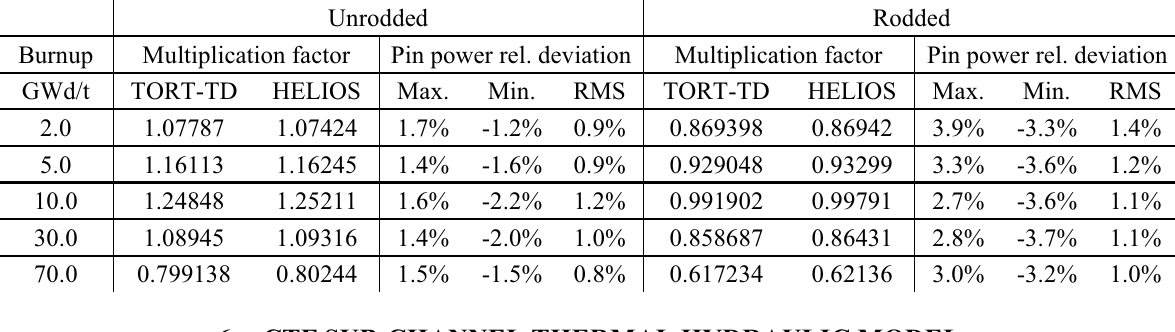
Table 2. TORT-TD multiplication factors as well as maximum, minimum and RMS deviations of the pin power distributions w.r.t. HELIOS for the middle zone at different burnup values.